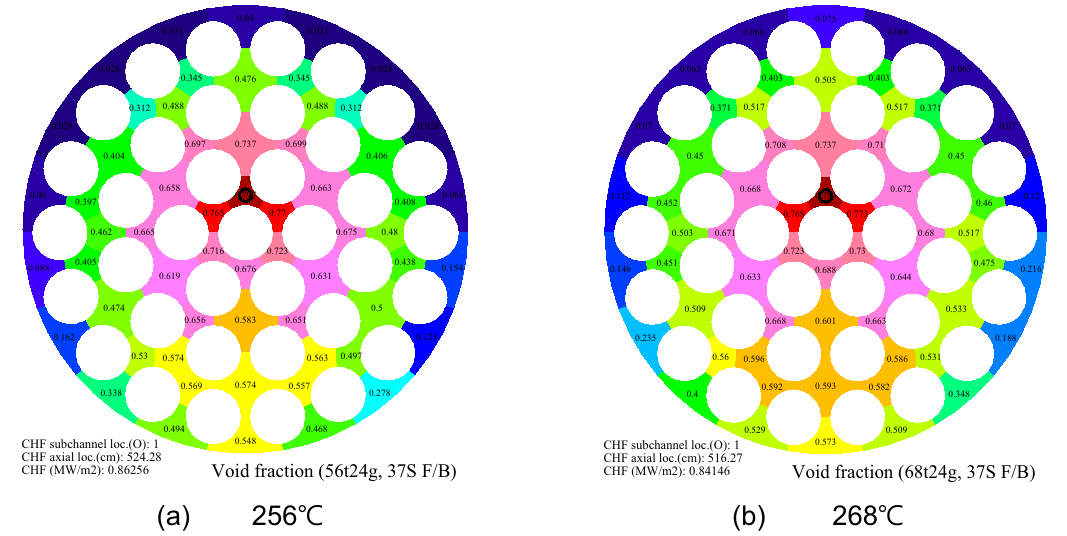
Fig. 7. Void fraction of a 37S fuel bundle for the 3.3% crept pressure tube at 24 kg/s.